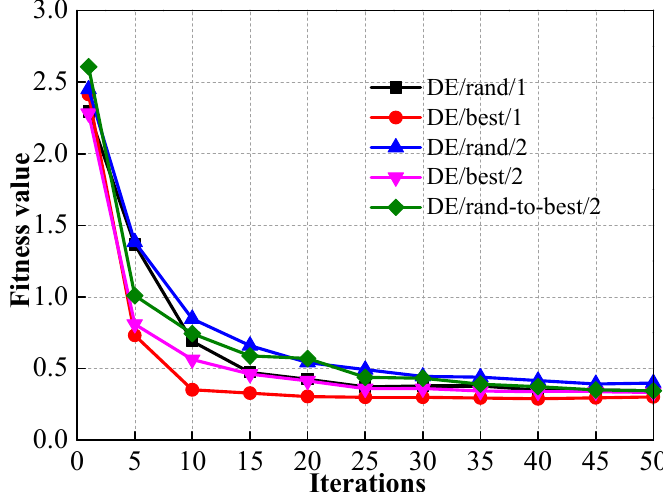
Figure 12. Various difference strategies.